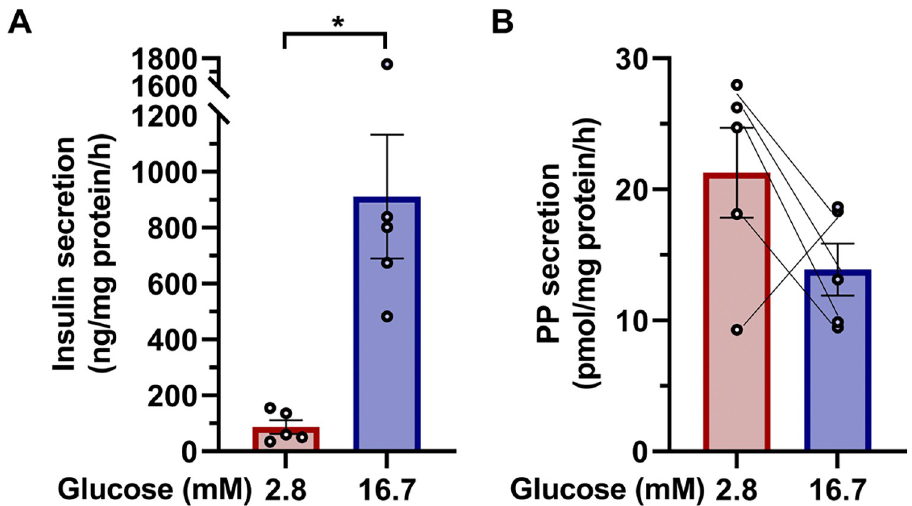
Fig 4. Analysis of glucose-stimulated PP secretion. Insulin (A) and PP (B) secretion from islets from the head region of the pancreas of 10-week-old WT mice, stimulated by 2.8 mM or 16.7 mM glucose for 1 hour (n = 5 mice). Values were normalized by the amount of protein from islets in the head region of the pancreas of WT mice. Data are shown as the mean ± SEM, and analyzed by the two-tailed unpaired t -test. � p < 0.05.